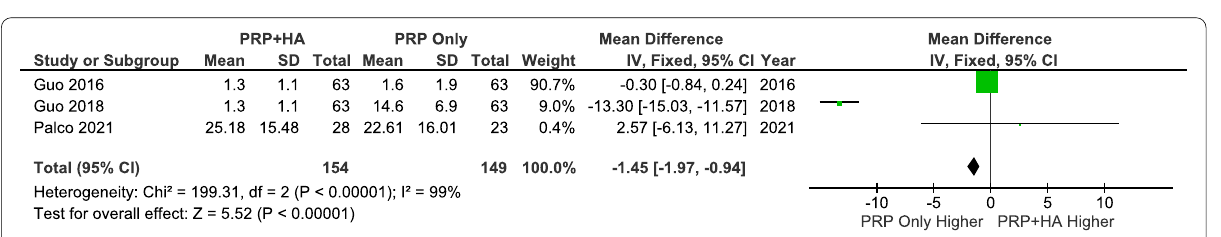
HA and PRP at 12 months after treatment +